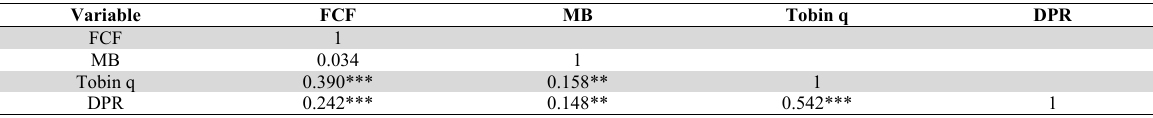
Correlation Matrix of The Main Constructs Variable